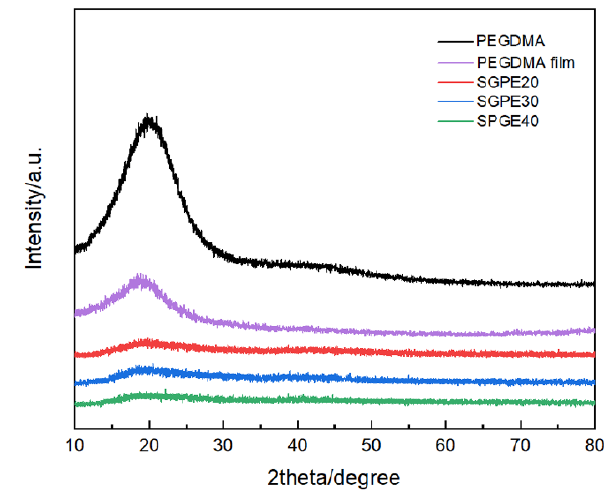
Figure 7. X-ray diffraction (XRD) pattern of pure PEGDMA, PEGDMA film, and SGPEs.